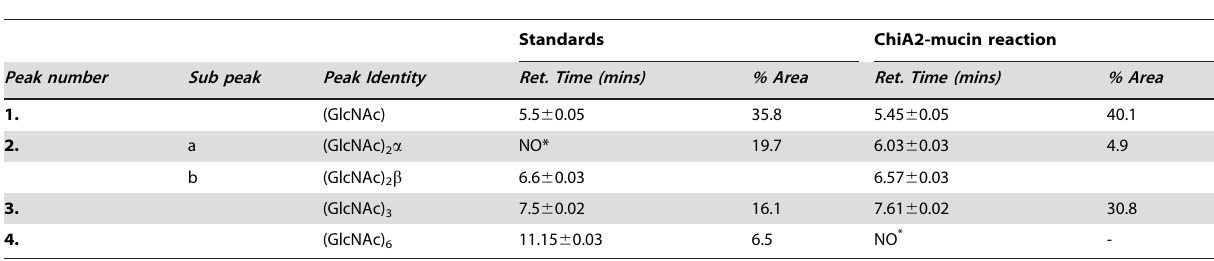
Table 2. HPLC analysis of the end products of ChiA2 treated